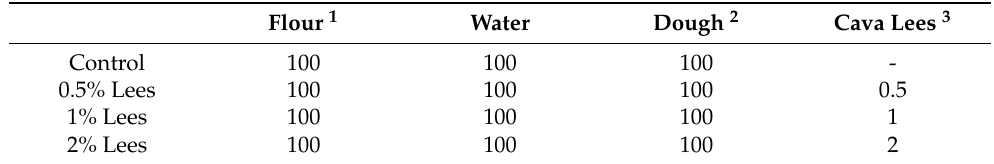
Table 1. Ingredients of sourdough (flour weight basis,